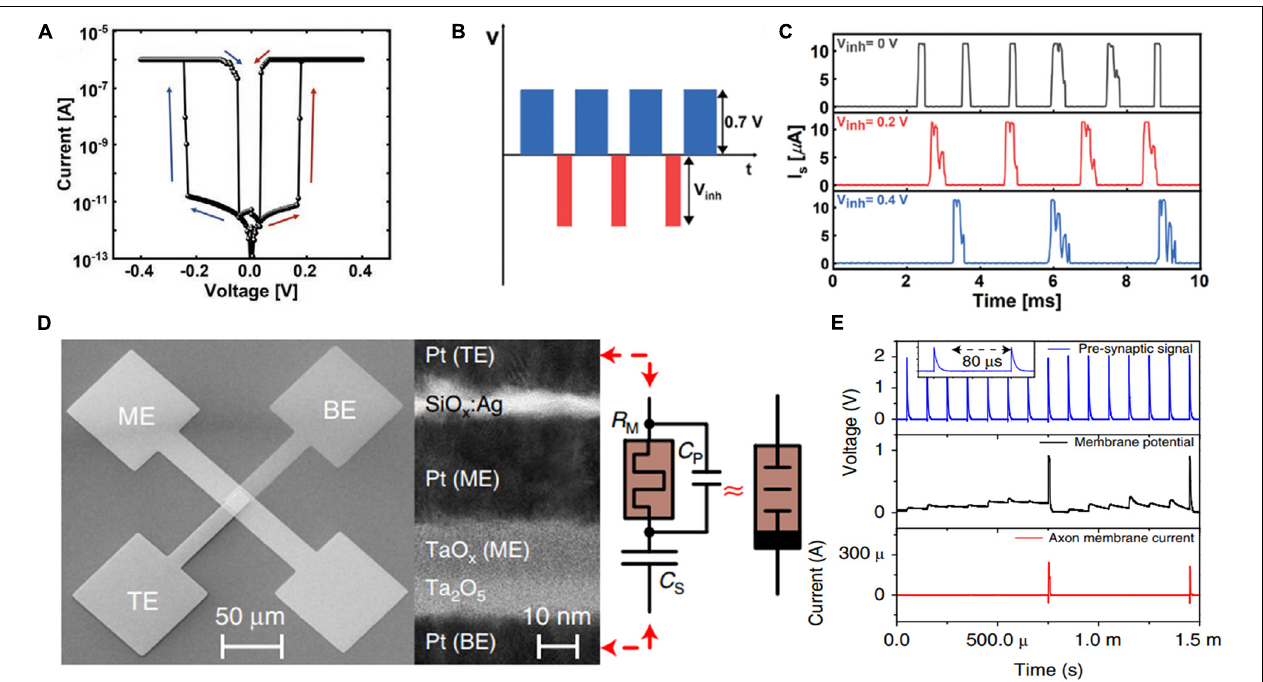
FIGURE 6 | (A) Ovonic threshold switching (TS) behavior in Ag/HfO 2 /Ag device. (B) Schematic of the input pulse program to verify the property of inhibitory postsynaptic potential (IPSP). (C) Firing rate modulation based on the inhibitory pulse amplitude in the opposite direction (Kim T. et al., 2020). (D) Scanning electron micrograph of the plane view of the integrated dynamic pseudo-memcapacitor and a transmission electron micrograph of the cross-section. (E) Dynamics of the neuro-transistor integrate-and-fire process, which exhibits the input pulse train (top panel), membrane potential (middle panel), and output spike sequence of axon membrane current (bottom panel) (Wang Z. et al.,